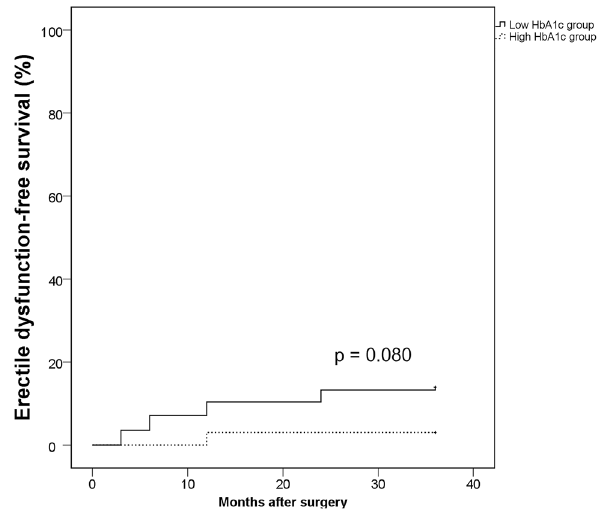
Figure 3. Kaplan–Meier analyses on the recovery of erectile dysfunction according to the preoperative